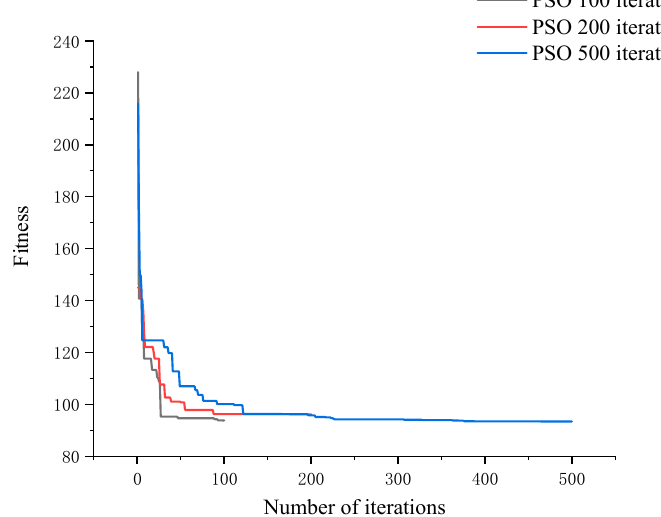
Figure 4. Fitness of PSO algorithm.